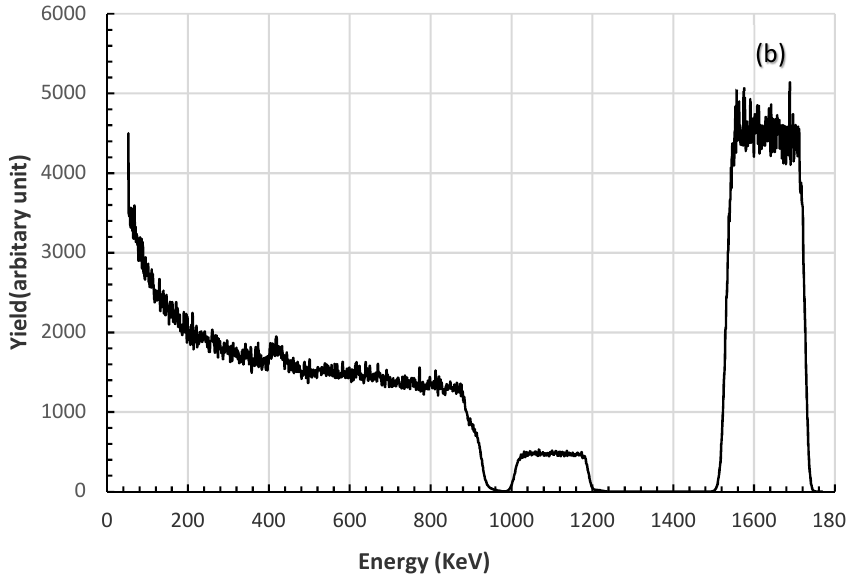
Figure 3. Two representative RBS spectra in the training dataset and their corresponding structural parameters of the physical samples ( a ) t = 3641.19 × 10 15 atoms/cm 2 , c 1 = 0.5105, c 2 = 0.3595 ( b ) t = 1361.46 × 10 15 atoms/cm 2 , c 1 = 0.4417, c 2 = 0.4283.